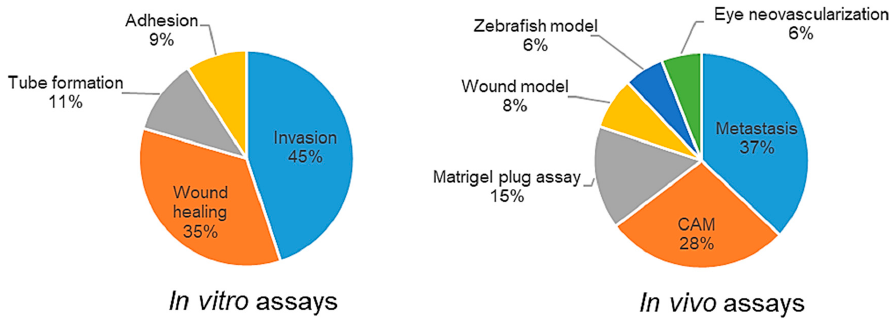
Figure 4. Types of assays used for in vitro and in vivo antiangiogenic evaluation of flavonoids.